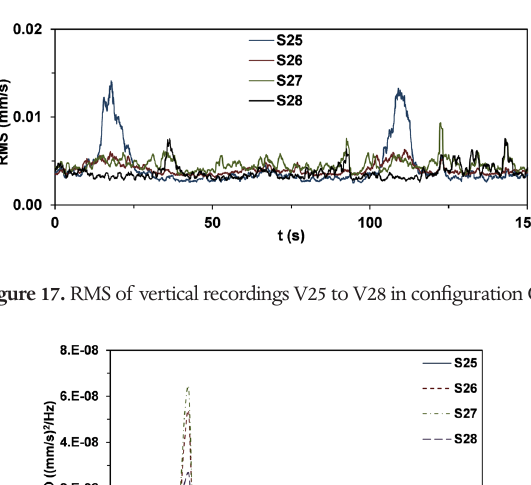
Figure 16. RMSs of vertical recordings in configuration C4.